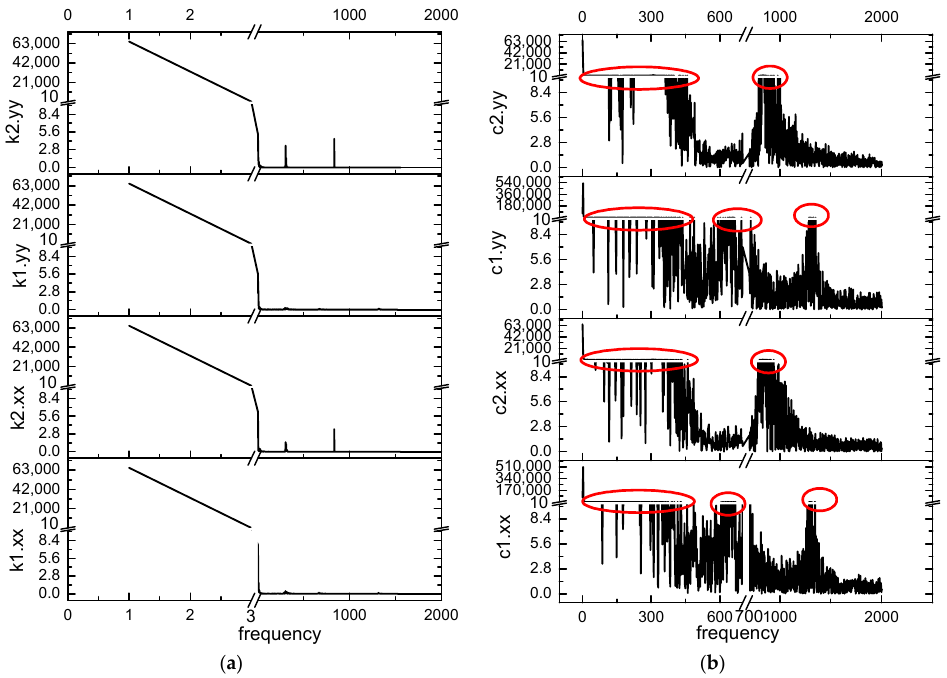
Figure A2. Identified bearing coefficients changing with frequency of g4.4 based on Algorithm I considering adjustment point and sensor resolution 1 nm: ( a ) obtained main stiffness coefficients in x and y directions; ( b ) obtained main damping coefficients in x and y directions.